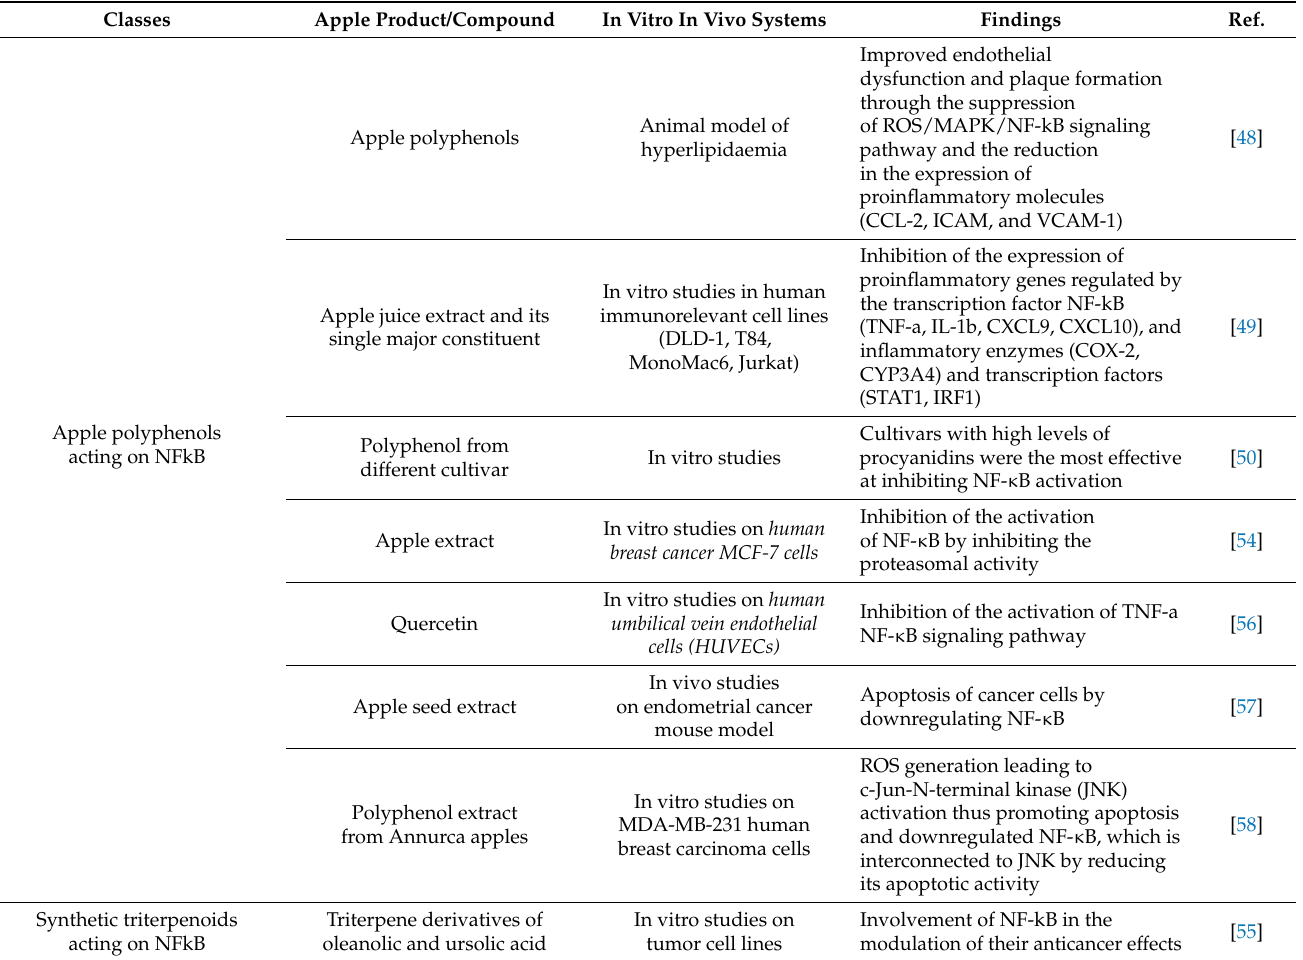
Table 2 summarizes the compounds/classes acting on the NF- κ B pathway. Table 2. Summary of the compounds/classes acting on the NF- κ B pathway, the tests performed and results